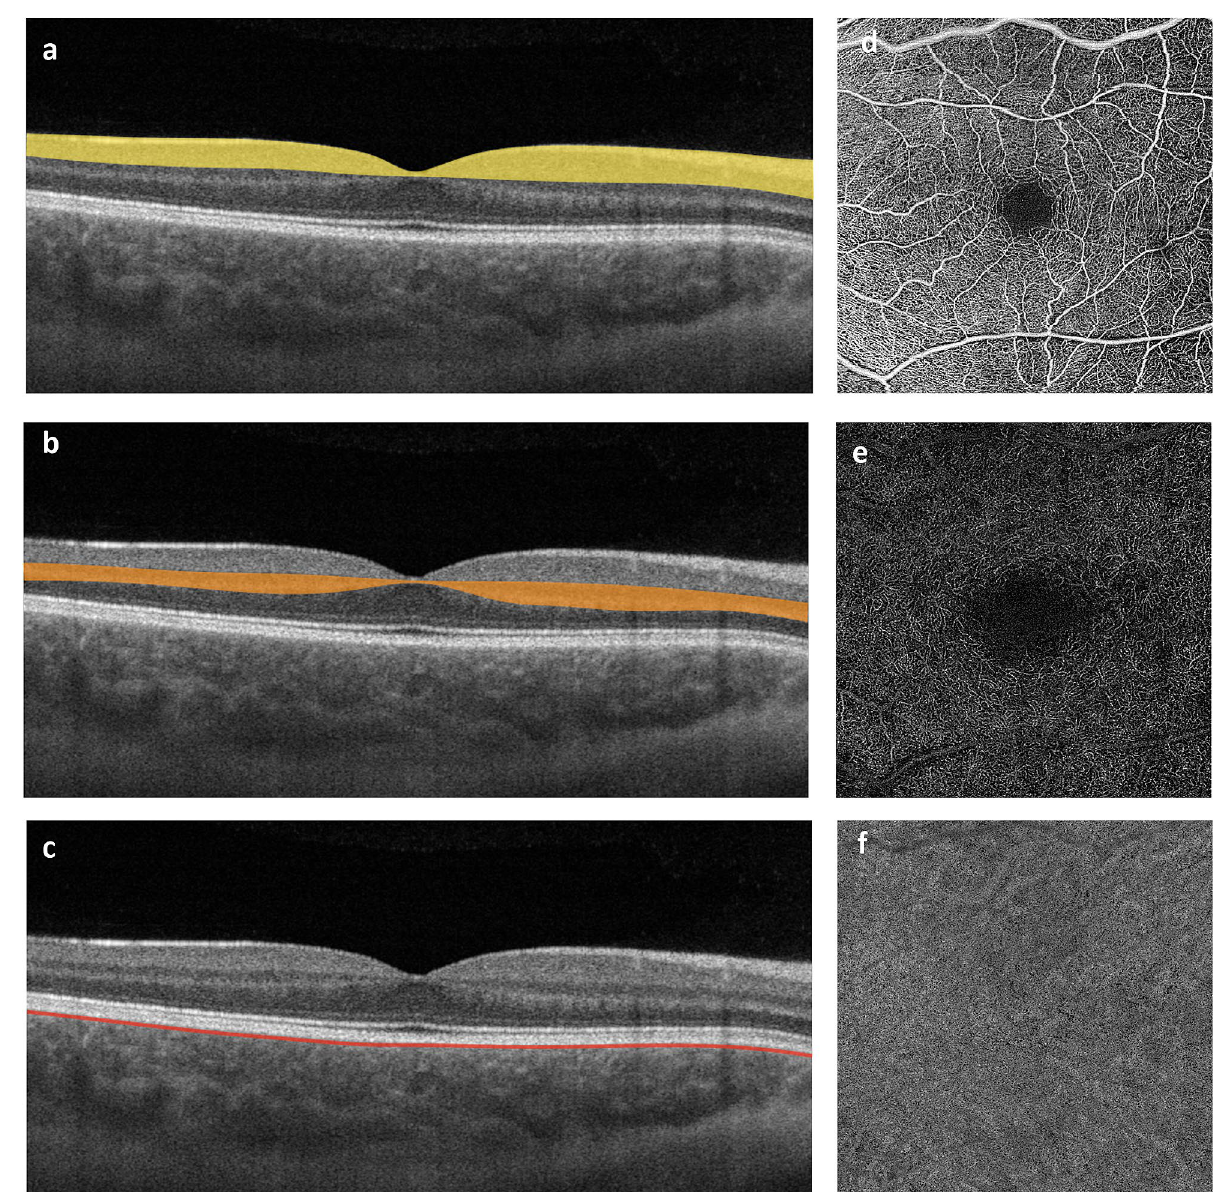
images (coronal plane; d , e , f